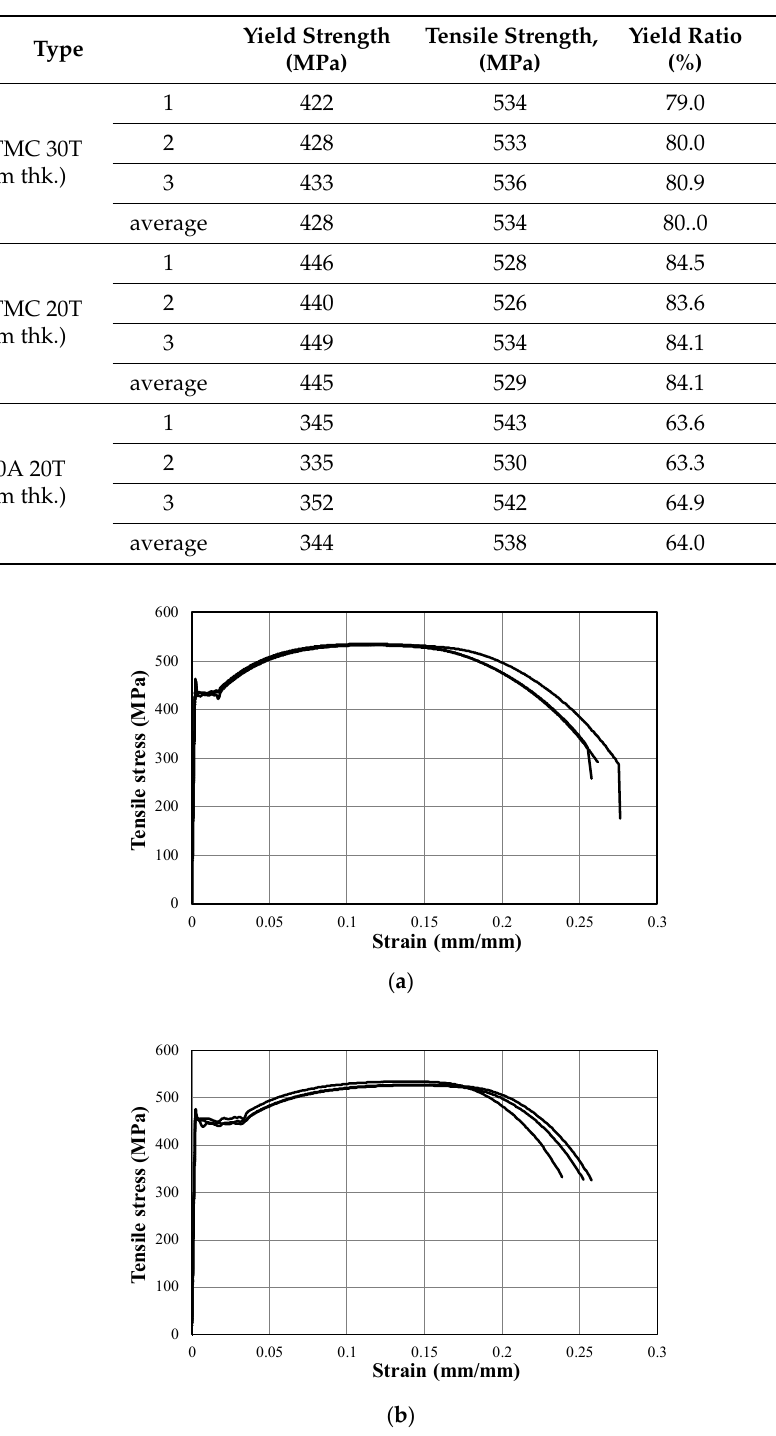
( c ) Figure 3. Tensile test result ( a ) SM490TMC-30T (30 mm thk.); ( b ) SM490TMC-20T (20 mm thk.); ( c ) SM490A-20T (20 mm thk.). 3.2. Direct Tensile Test at Welding Joint To evaluate the performance of welded connections with non-uniform section properties and simplified details suggested in this study, split T test specimens were fabricated and tested as shown in Figure 4. A pair of the specimens were considered for each of two series specimens: U series specimens are the welded connection between the plates with the same material property (i.e.,